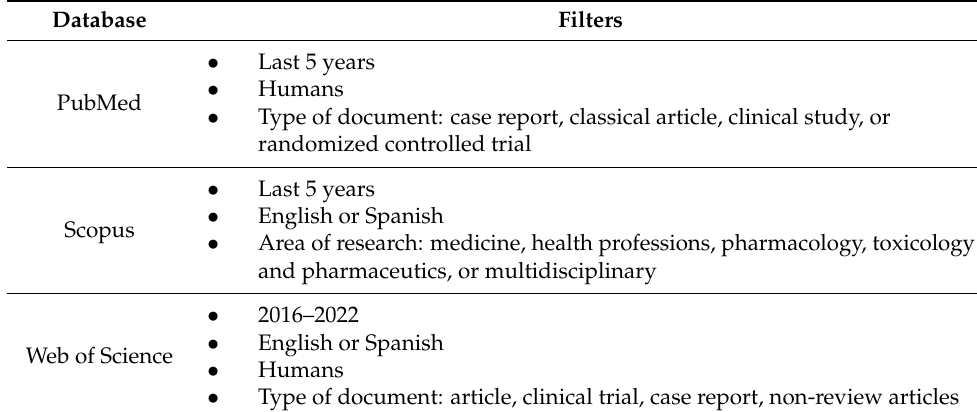
Table 1. Parameters of the systematic academic literature